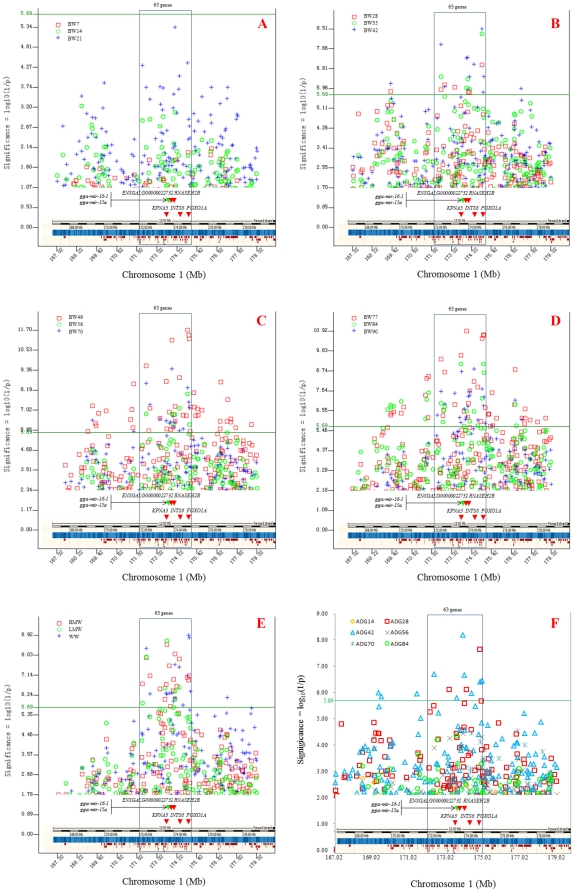
SNP effects on chicken growth traits in the 167–179 Mb region of GGA1.The green line was the 5% Bonferroni genome-wide significance threshold. The rectangular box with blue border framed the 3 Mb region of GGA1 (172–175 Mb) with the most significant effects for all 23 traits. Red arrows highlight genes and the green arrows are the two non-coding RNA genes.